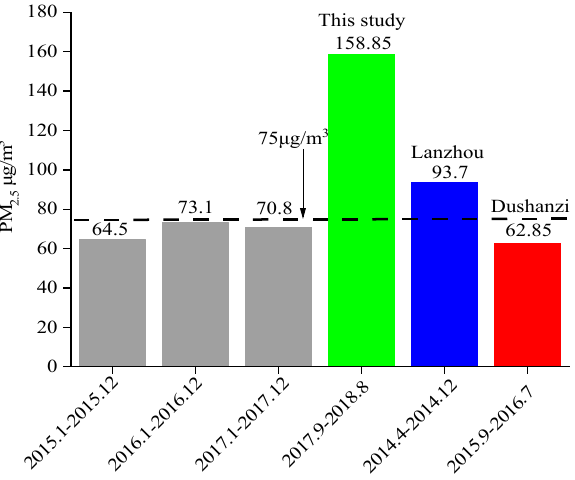
Figure 2. Time series of meteorological records and PM 2.5 during the sampling time. The annual average mass concentration was 158.85 ± 15.11 μ g/m 3 . The PM 2.5 concen- tration in autumn was the highest with an average of 180.49 ± 87.22 μ g/m 3 , and the average concentration in summer was the lowest at 148.41 ± 52.60 μ g/m 3 , with a difference of 32.08 μ g/m 3 . The annual average daily mass concentration of PM 2.5 (Figure 2) mostly exceeded the national secondary standard (75 μ g/m 3 ), indicating that Urumqi’s atmospheric PM 2.5 pollution was at a high level. Figure 3 shows the concentration changes of PM 2.5 in Urumqi since 2015 [16]. From the figure, it can be seen that the mass concentration of PM 2.5 in Urumqi increased from 2017 to 2018, which is twice as much as that in 2015–2017. This may have been mainly due to the dust released during the demolition of old houses in the Tianshan District of Urumqi with the development of the city [17]. The mass concentration of PM 2.5 in this study was higher than that in Lanzhou City [18] of Gansu Province (93.7 ug/m 3 ) and Dushanzi District [19] of Xinjiang (62.85 ug/m 3 ).